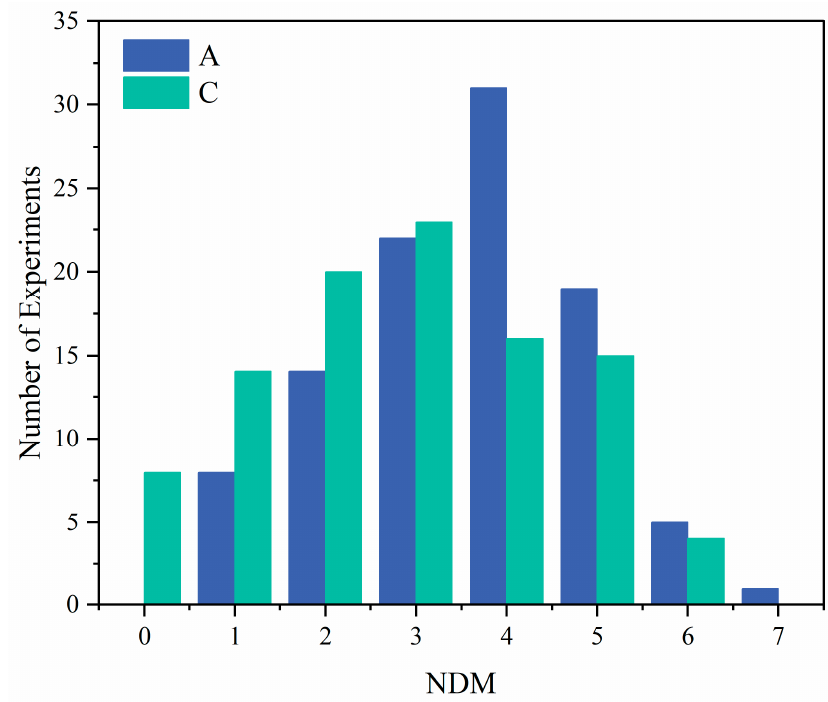
Figure 8. NDM in A and C ( t = 100).